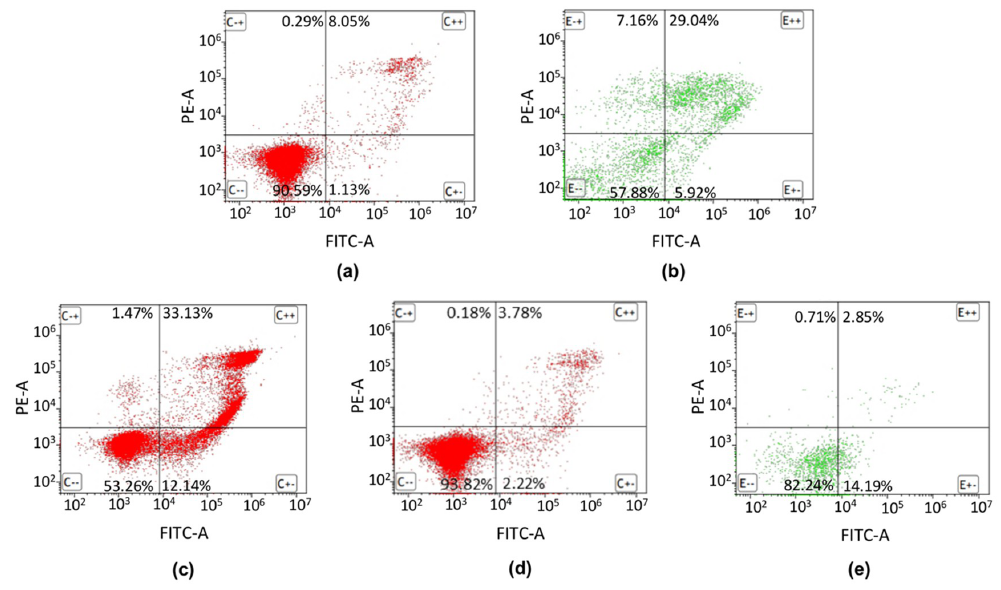
Figure 3. Flow cytometric FITC annexin V / propidium iodide (PI) double staining analysis of apoptosis. ( a ) negative control; ( b ) positive control; ( c ) OptiBond Universal; ( d ) Prime&Bond Universal; ( e ) Adhese Universal. Dot plot graphs indicate the percentage of viable (FITC annexin V negative, PI negative), early